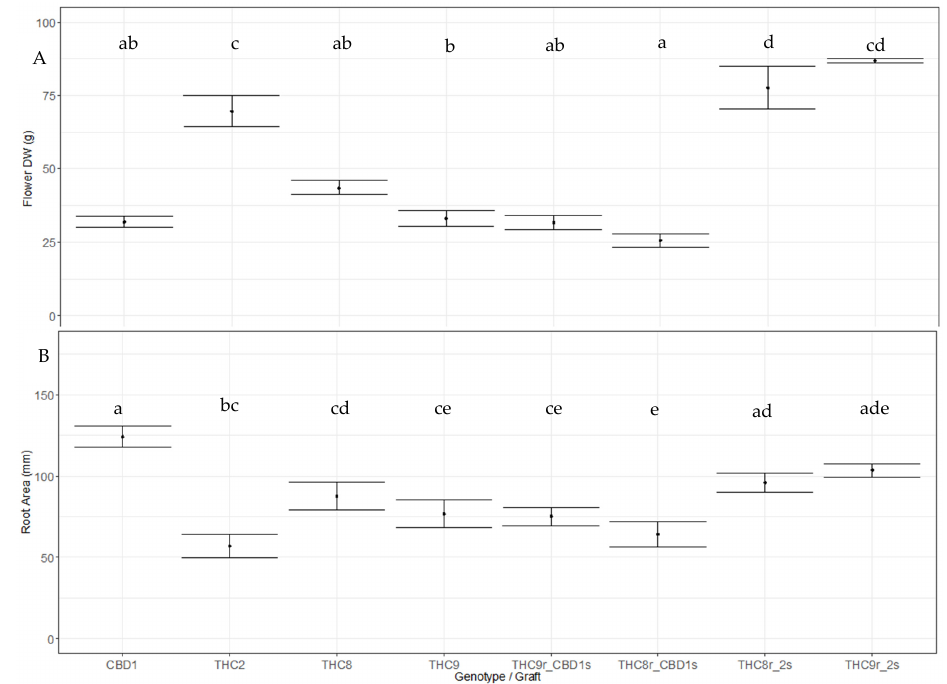
Figure 5. A and B: Flower yield (g DW plant − 1 ) ( A ) and root area ( B ) from control and grafted plants. Letters above the bars denote significant differences (Tukey HSD, p ≤